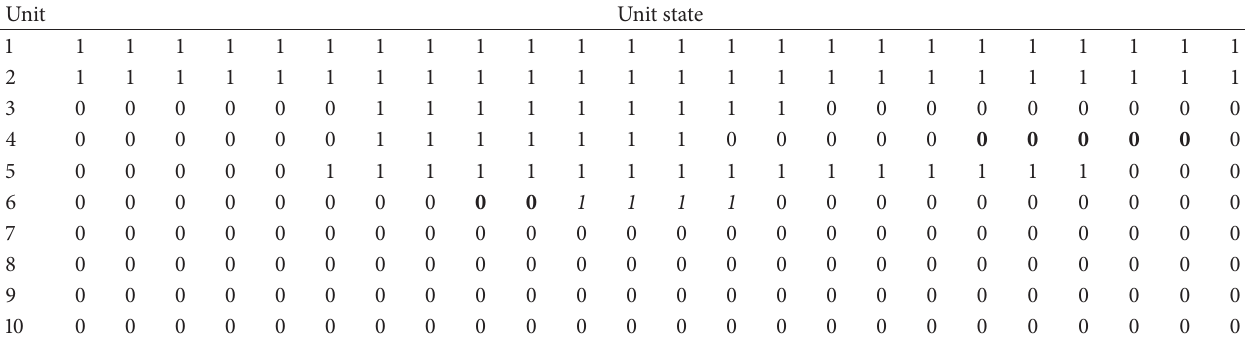
Table 6: The final UC decision using proposed model in wind scenario group 1-1.